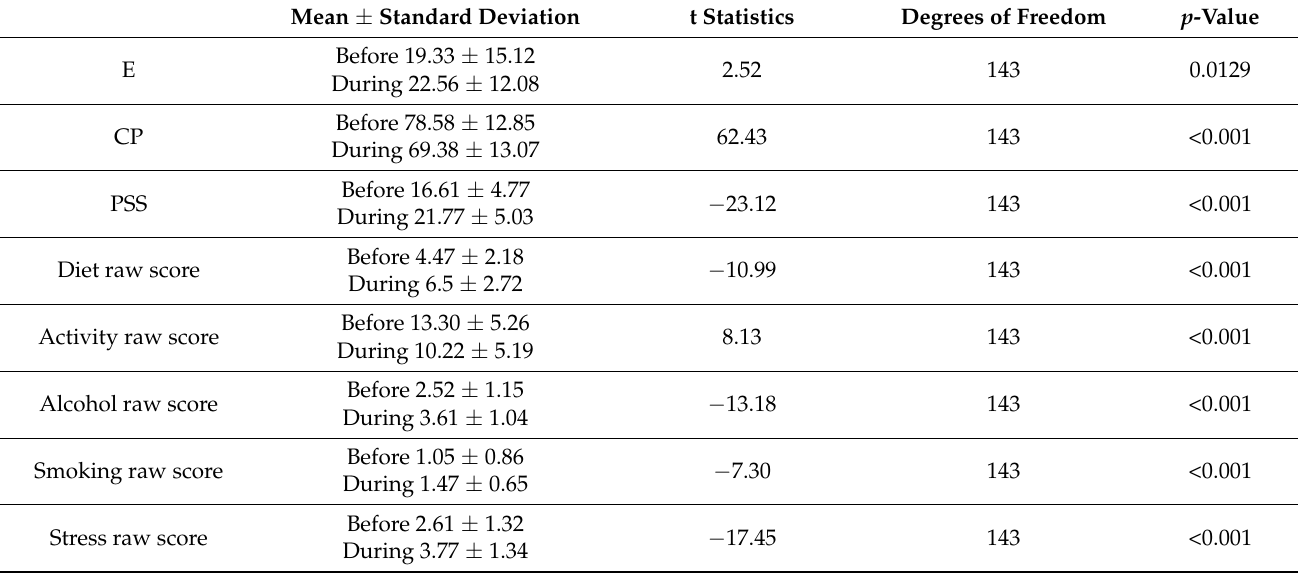
Table 1. Stress, cognitive performance, and lifestyle among participants before and during the confinement. Mean ± Standard Deviation t